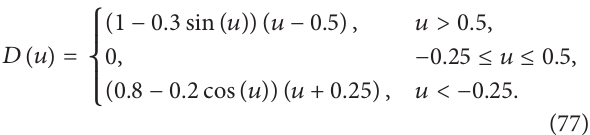
Figure 1: Trajectories of system output 𝑦 and reference signal 𝑦 𝑑 .